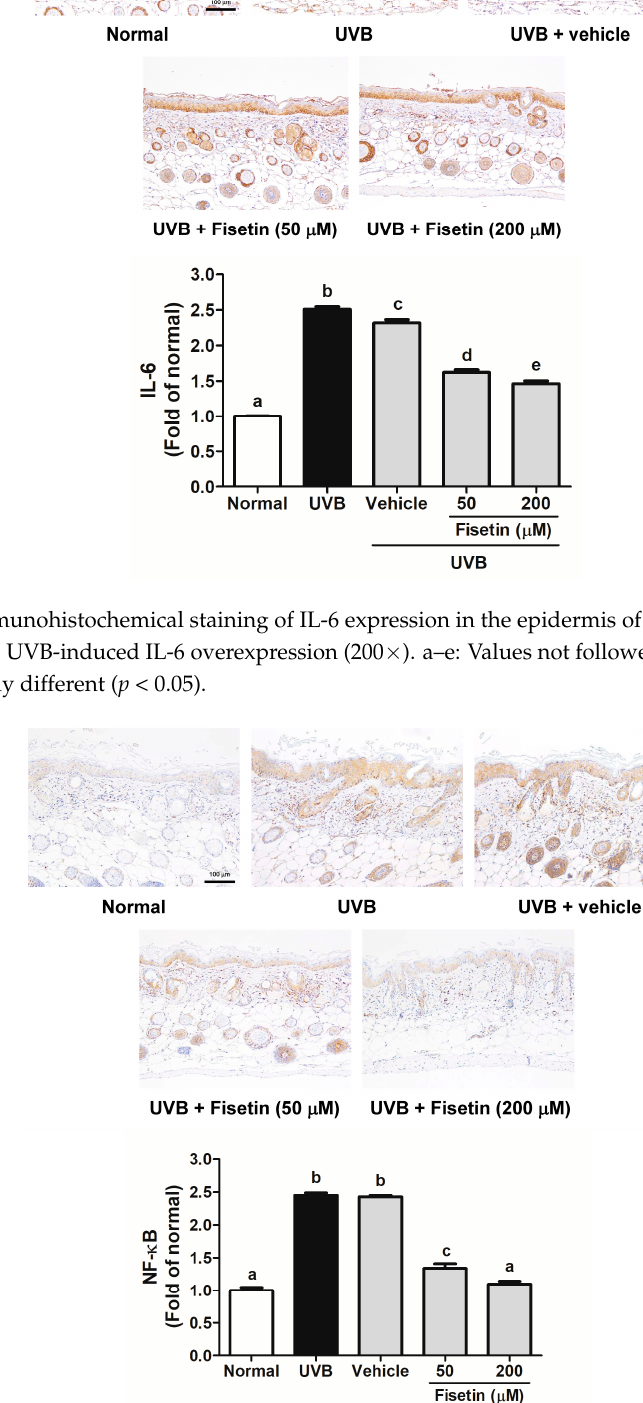
Figure 11. Immunohistochemical staining of NF- κ B expression in the epidermis of the mouse skin slices. Fisetin inhibits UVB-induced NF- κ B overexpression (200×). a–c: Values not followed by a common letter are significantly different ( p < 0.05).